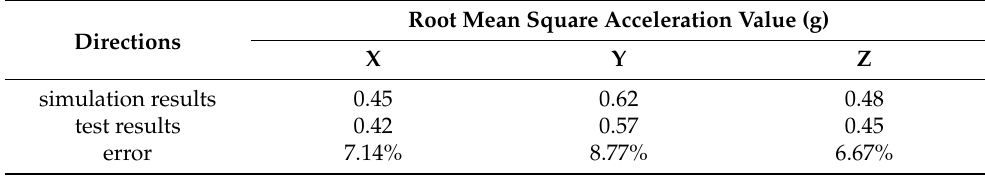
Table 5. Comparison of simulation and test rms acceleration